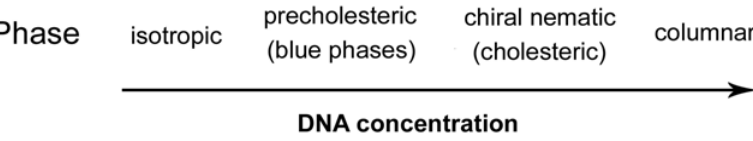
Figure 2. The schematics of nucleic-acid based liquid crystal phases. Adapted with permission from